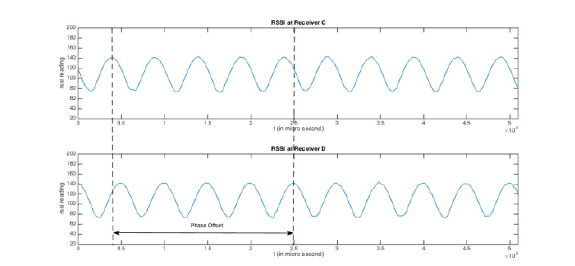
Fig. 4. Phase Offset of Two Average-RSS-Time